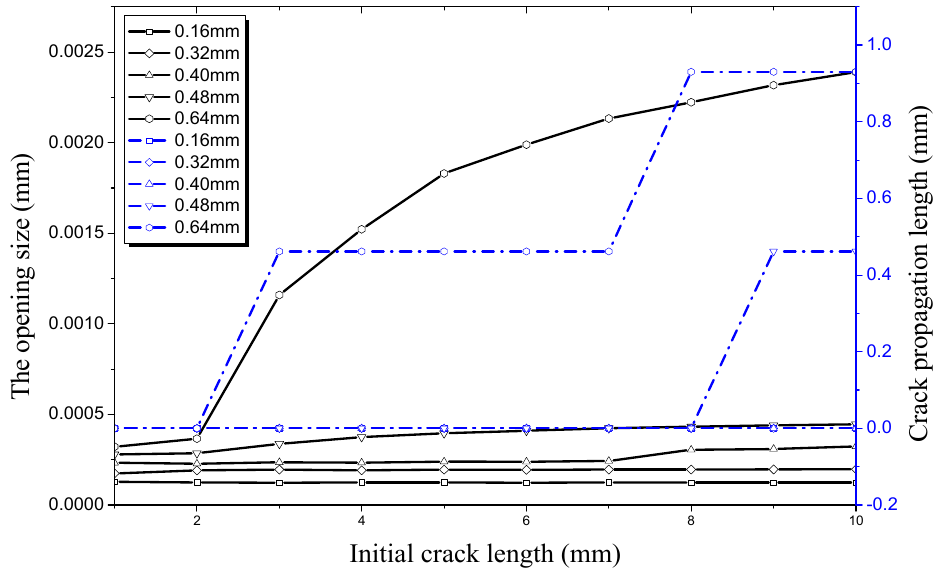
Figure 14. Relationship between longitudinal crack propagation length and initial crack length on the outer surface, and relationship between longitudinal opening size and initial crack length on the outer surface, both under an internal pressure of 21 MPa.